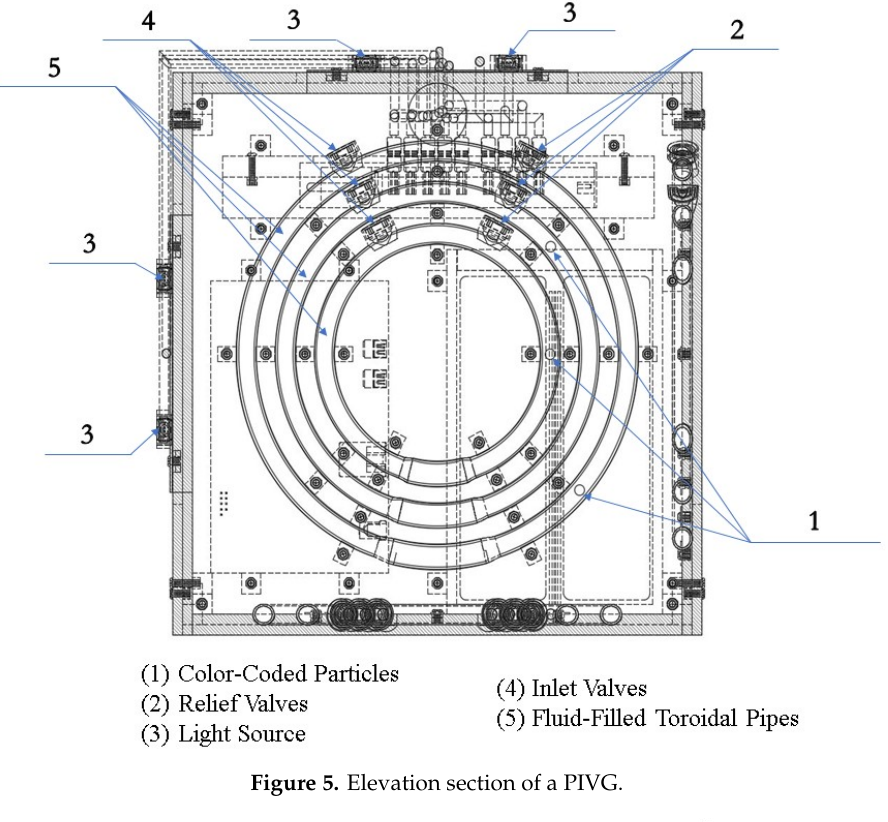
Figure 5. Elevation section of a PIVG.